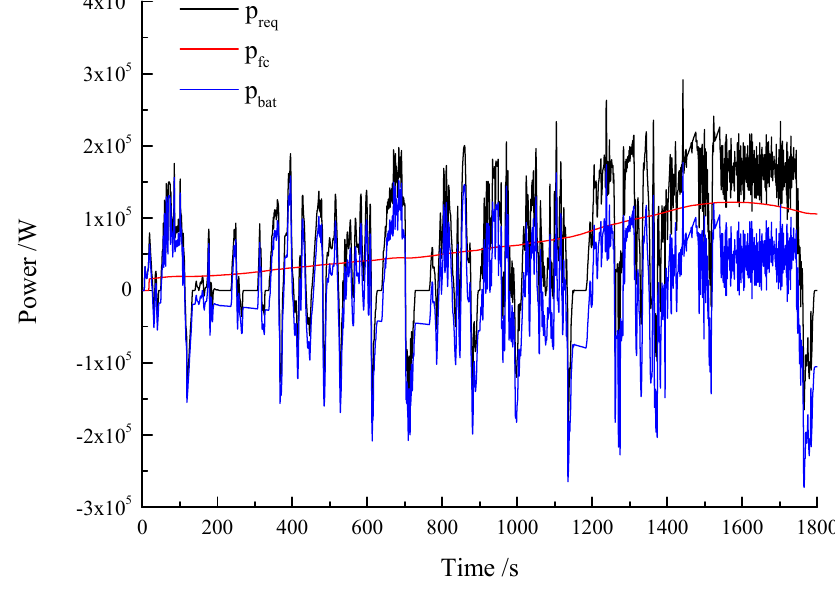
Figure 11. Relationships between power output and power demand by two energy sources.